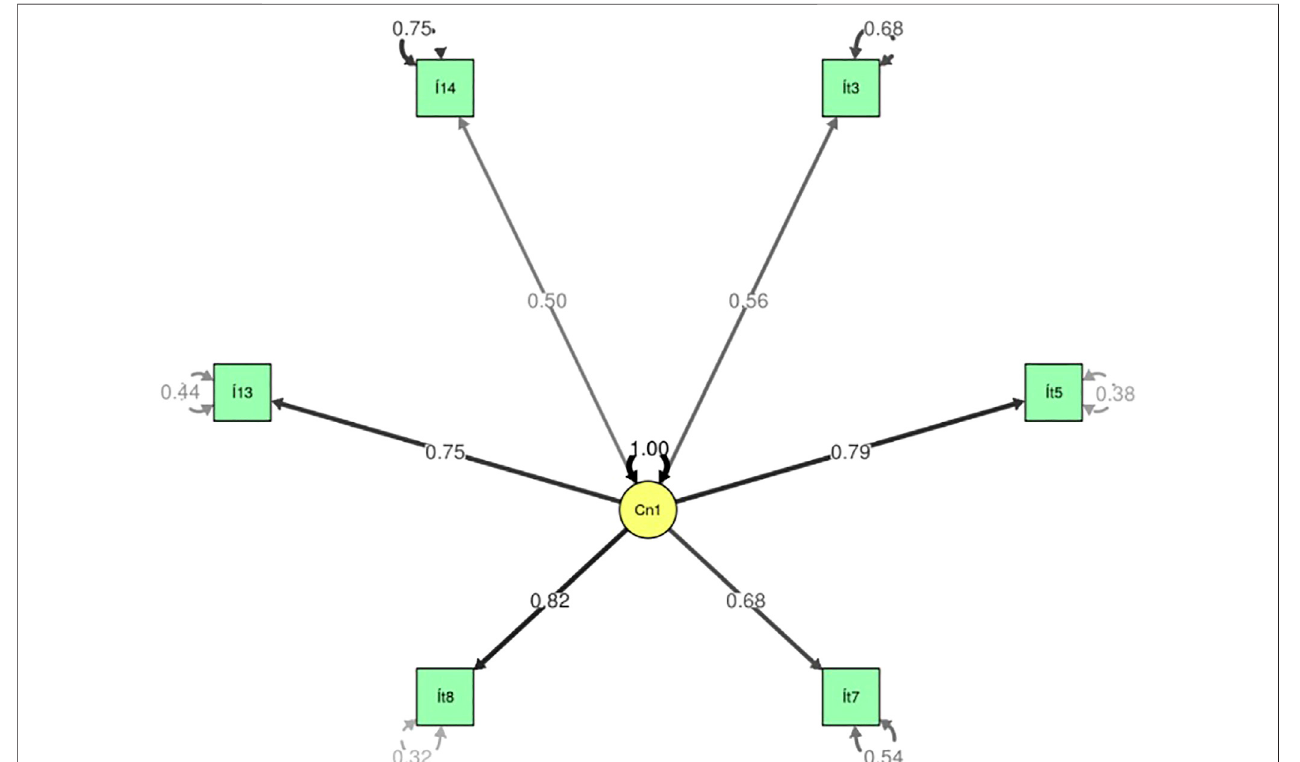
FIGURE 1 | Structural equation model. Factor